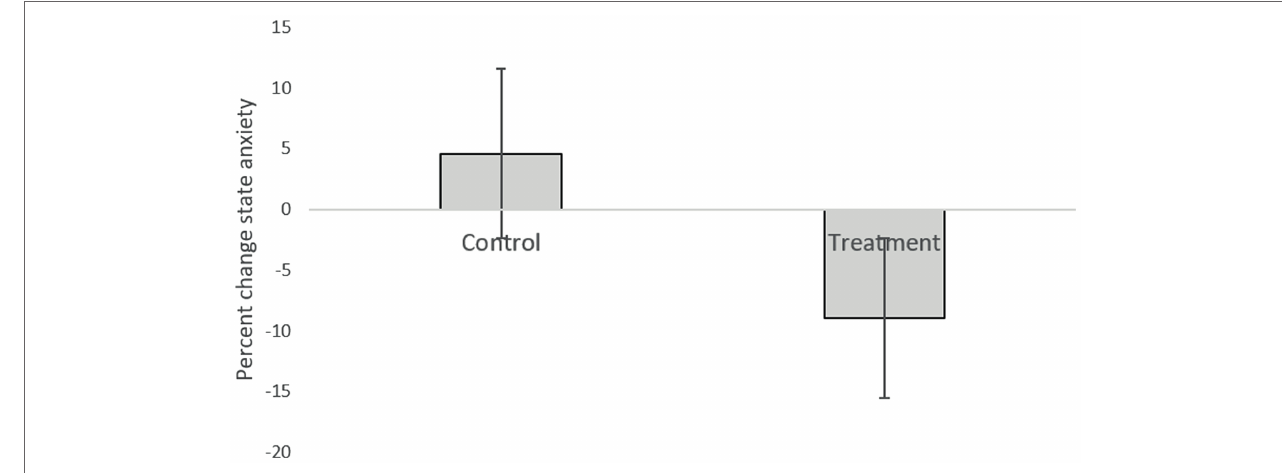
FIGURE 3 | Anxiety level difference between the two lab visits in both the treatment and control groups.